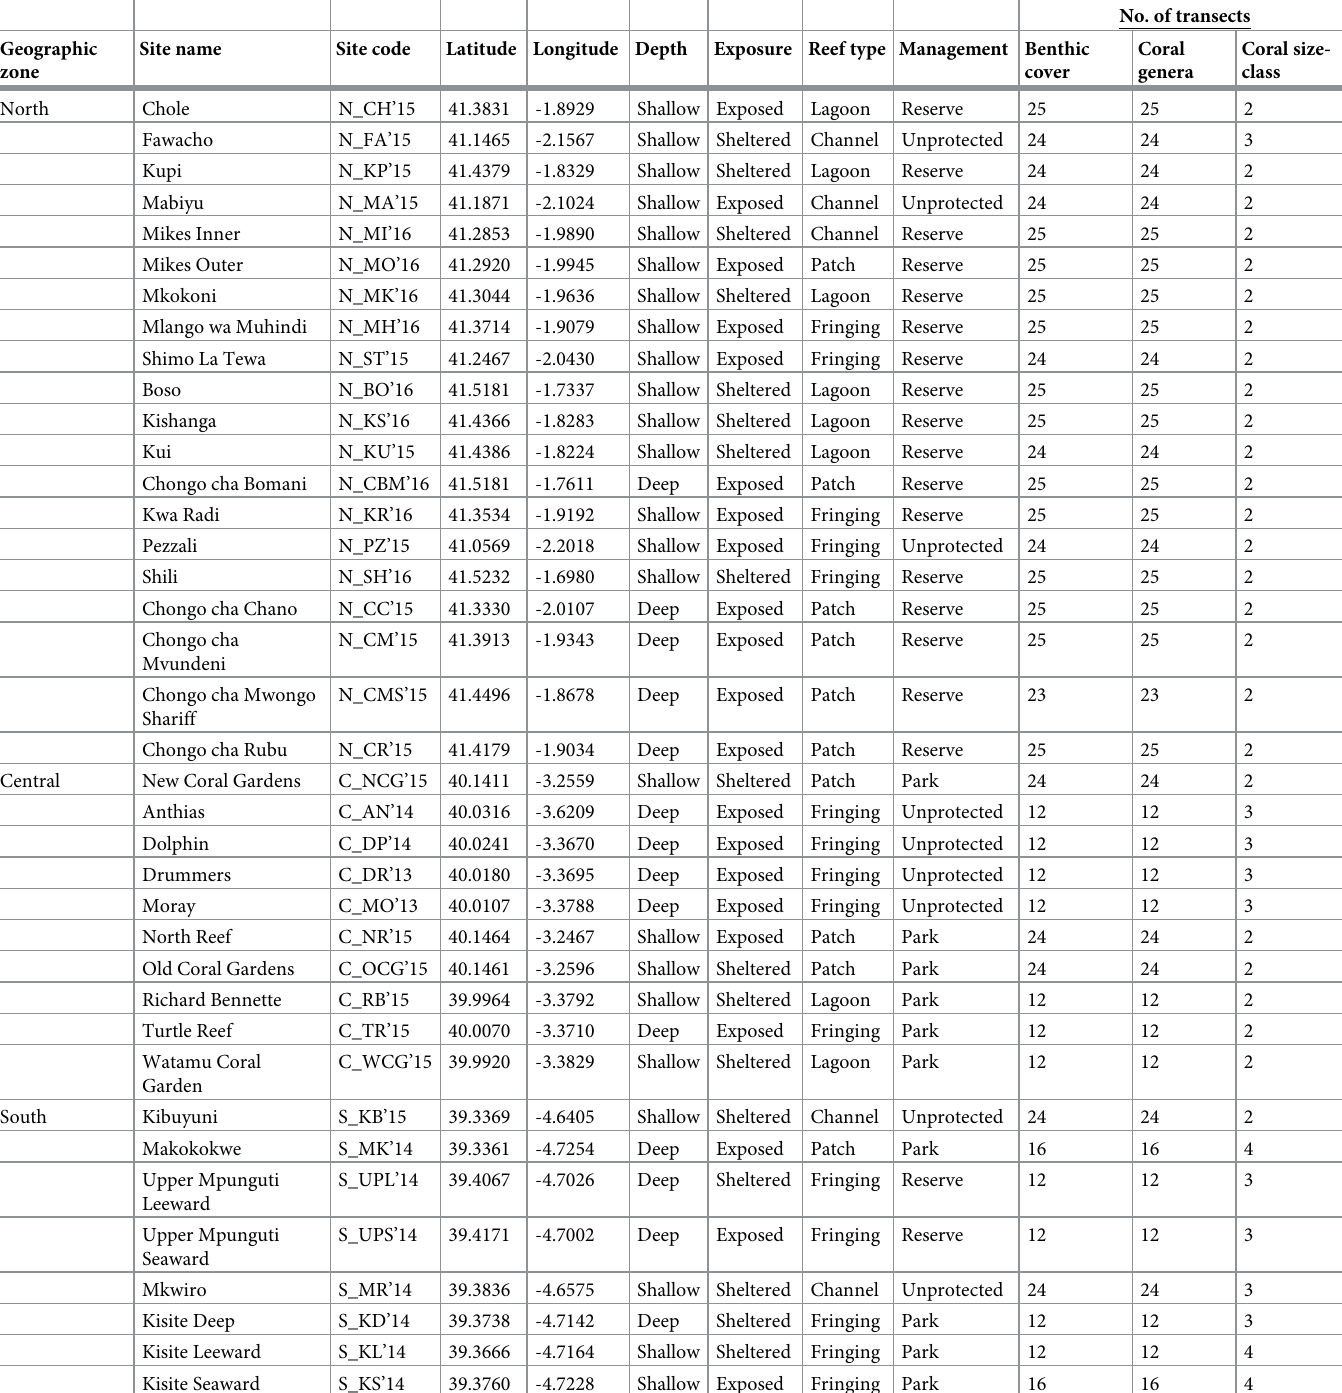
Table 1. Summary of study sites at three geographical zones. Site habitat characteristics (depth, exposure, reef type) and management level including their correspond- ing number of transects surveyed for each benthic community along the Kenyan coast.